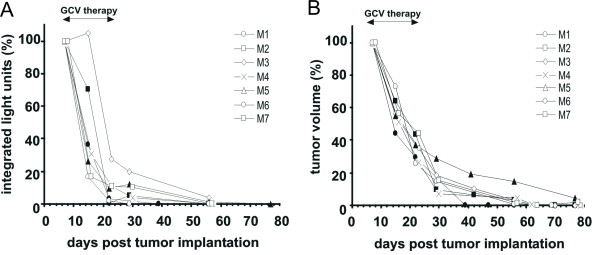
Comparison of (A) bioluminescence signals detected by the CCD camera and (B) tumor volumes in GCV-treated mice (n= 7, M1 – M7) harboring HSV-TK-Luc tagged U87MG glioma xenografts. GCV (60 mg/kg per day) was administered for 14 days starting at day 7 post tumor implantation. All mice were imaged at least on days 7, 15, 22, 29, and 56 post tumor implantation. BLI signals and tumor volumes at the beginning of therapy were set as 100%. Identical symbols in both graphs correspond to identical animals.